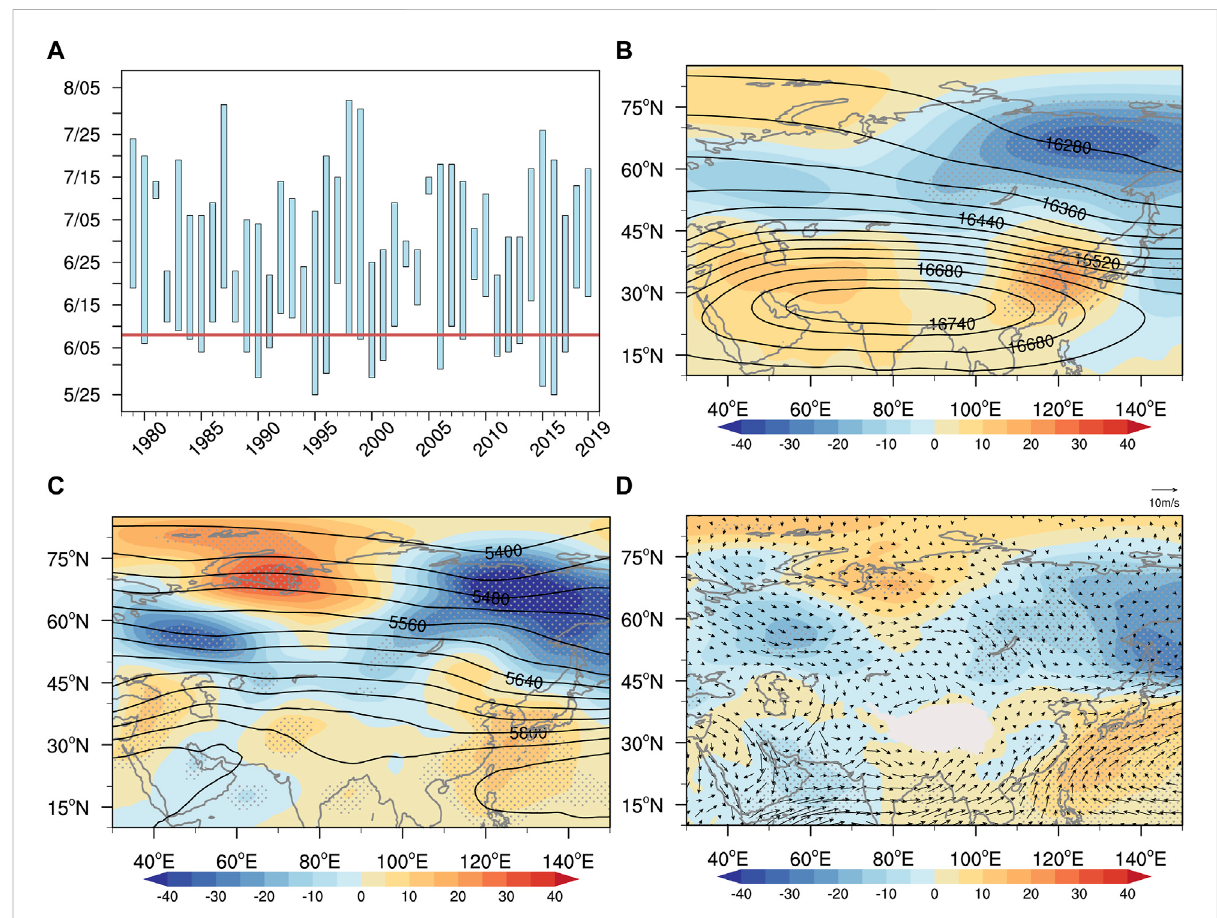
FIGURE 2 (A) Meiyu periods (blue bars) over the Jiangnan area and the climatic Meiyu onset day (red line) during 1979 – 2019. Geopotential height (contours, unit: gpm) and its anomaly (shading, unit: gpm) at 100 hPa (B) and 500 hPa (C) on the Meiyu onset day. Wind (vector, unit: m/s) and geopotentialheightanomaly(shading,unit:gpm)at850 hPa (D) ontheMeiyuonsetday(dotsaretheareaswithstatisticalsigni fi canceexceedingthe 95%